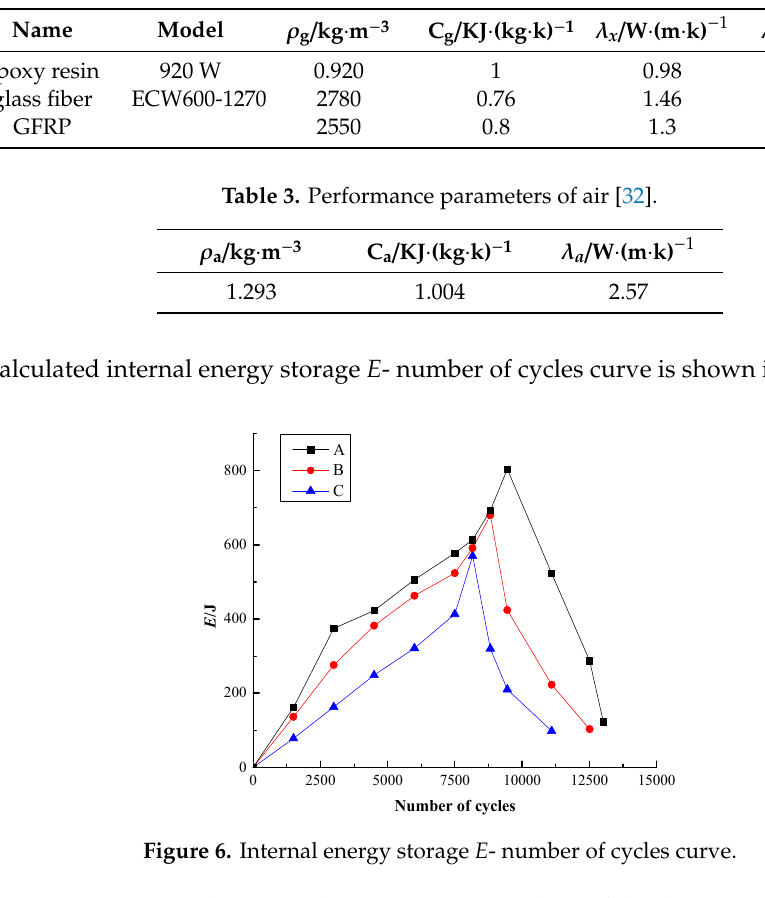
Table 2. Performance parameters of the glass-fiber-reinforced plastic (GFRP) composites.